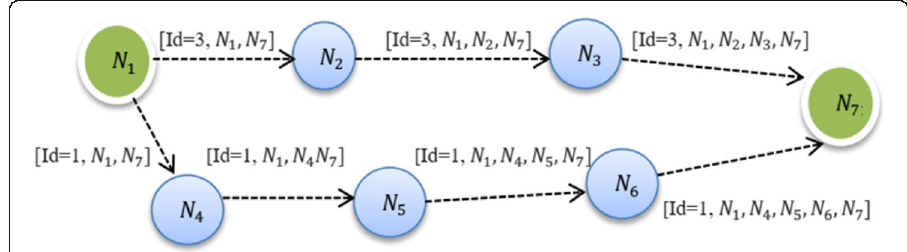
Fig. 1 Route discovery using RREQ packets. N 1 is the source and N 7 is the destination. To obtain the route, two RREQs with unique different ids (id = 3 and id = 1) will be sent and two paths will be discovered, which are route 1 [ N 1 , N 2 , N 3 , N 7 ] and route 2 [ N 1 , N 4 , N 5 , N 6 , N 7 ]. Route 1 will be selected as it has the minimum